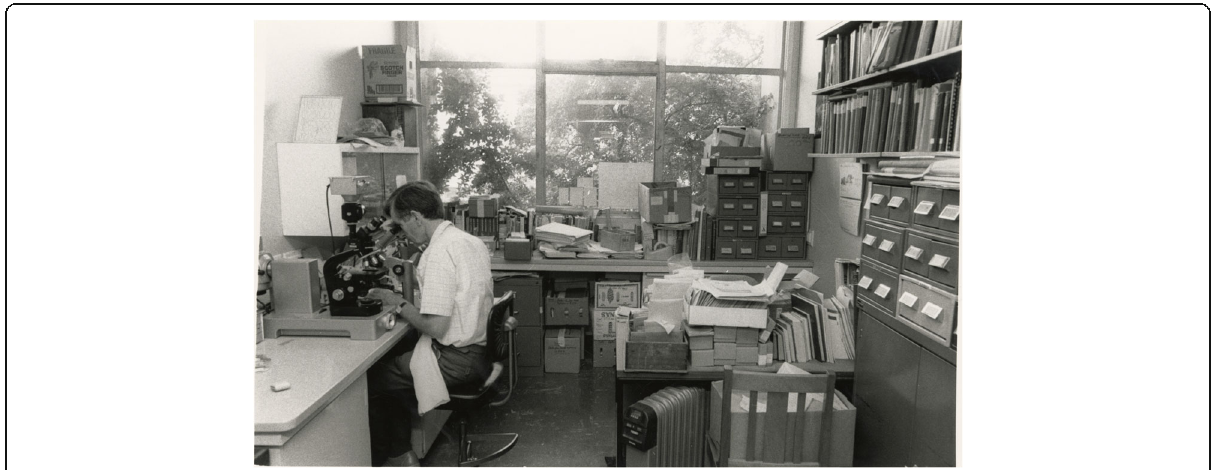
Fig. 23 John Walker in his office at the Biological and Chemical Research Laboratory, Rydalmere, 1988